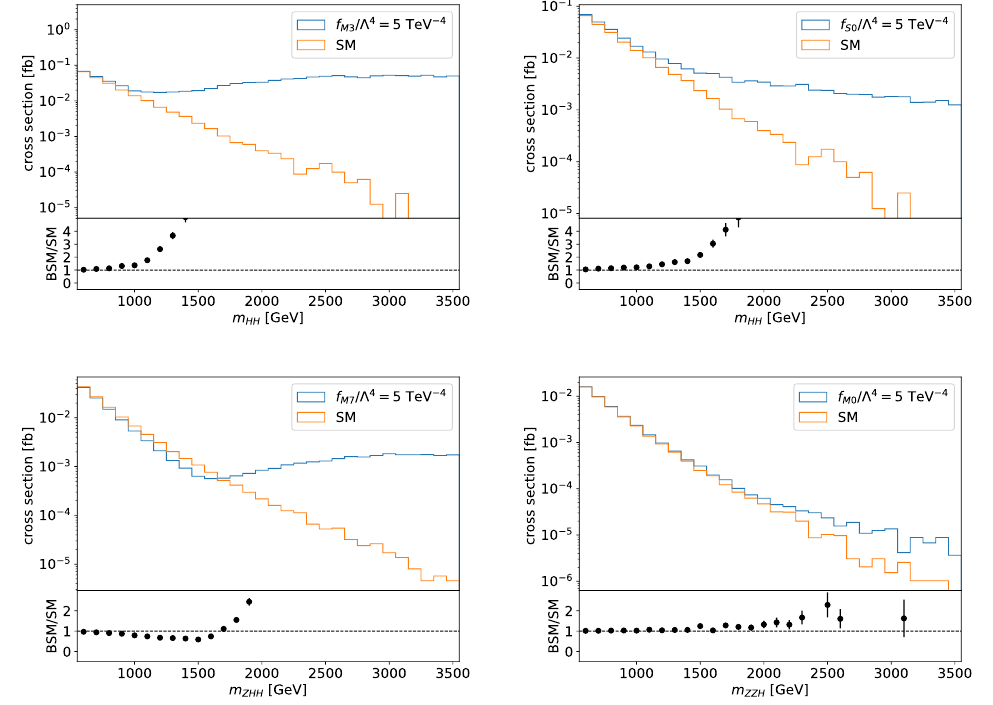
Figure 3 . Examples of differential cross sections highlighting the high invariant-mass region for the processes VBF-HH (top left/top right), ZHH (bottom left) and ggZZH (bottom right). The SM hypothesis is shown, as well as that of a single EFT operator (listed in the legend) with a